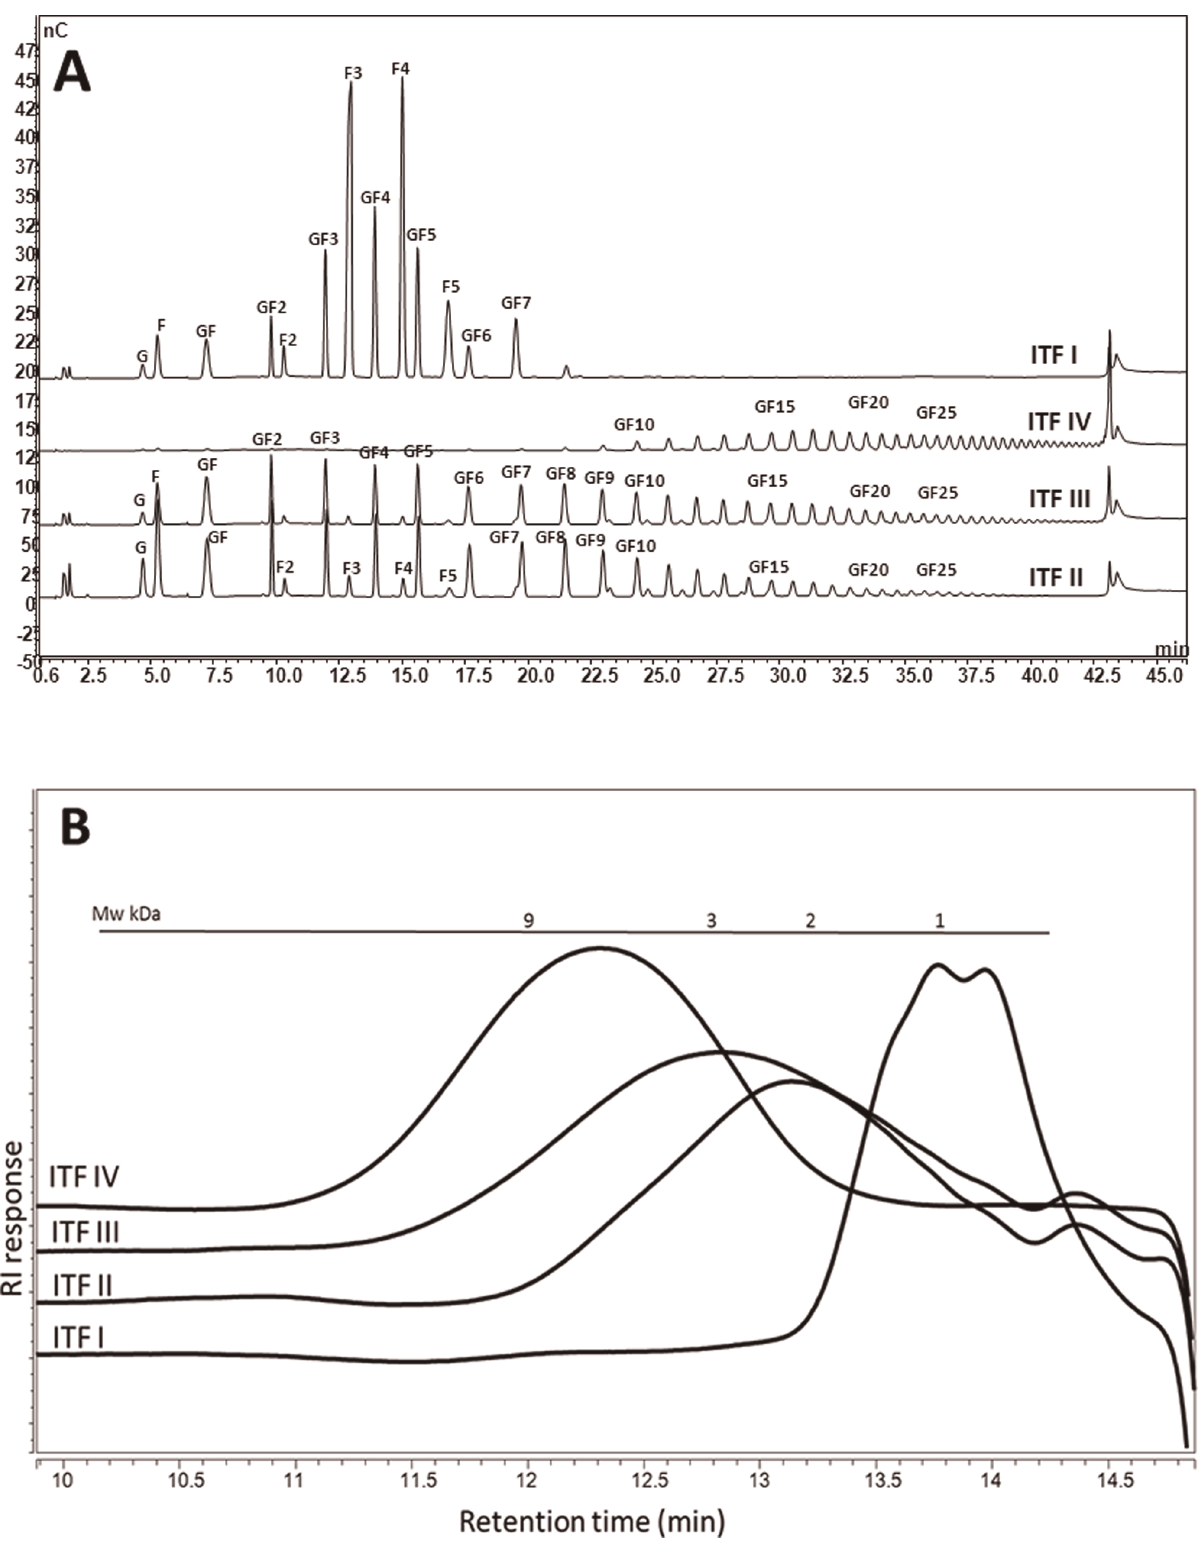
Figure 1. HPAEC profiles and HPSEC elution patterns of different b 2 R 1-fructan formulations. Figure A depicts the fructose (F) and glucose (G) monomers, dimers, and fructan oligomers present in the ITF formulations. GF n chains are terminated by a glucose molecule, and F n chains consist of only fructose moieties. In both cases, n represents the number of fructose moieties in the chain. Figure B depicts the elution patterns as a measure for molecular weight distribution profiles of the four different b 2 R 1-fructan formulations in kDa.